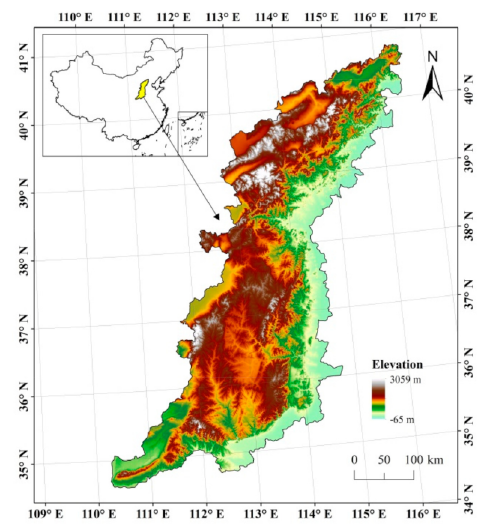
Figure 1. The study area of Taihang